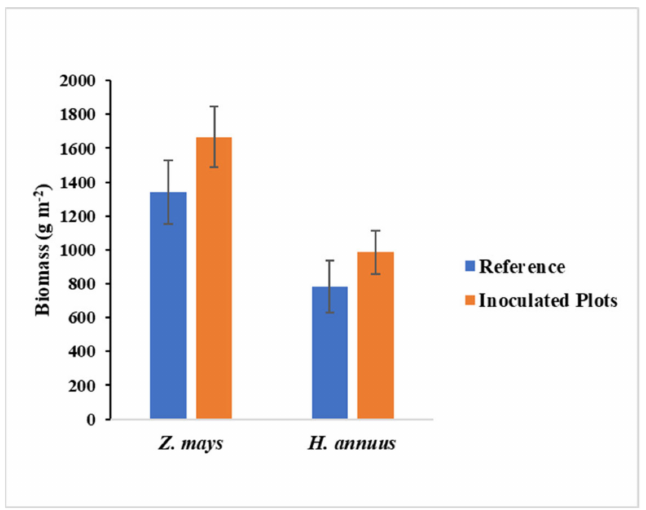
Figure 2. Effect of soil inoculation on biomass production by Zea mays and Helianthus annuus . Differences between means are not significant at p ≤ 0.05 (mean ± SE, n =